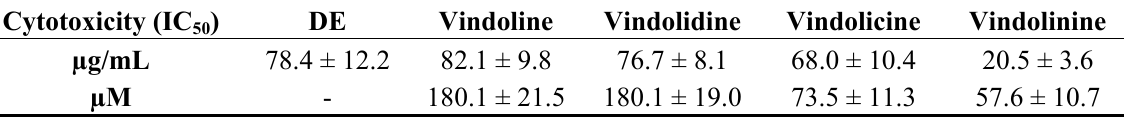
Table 1. β -TC6 cell viability under treatment of DE and alkaloids I – IV